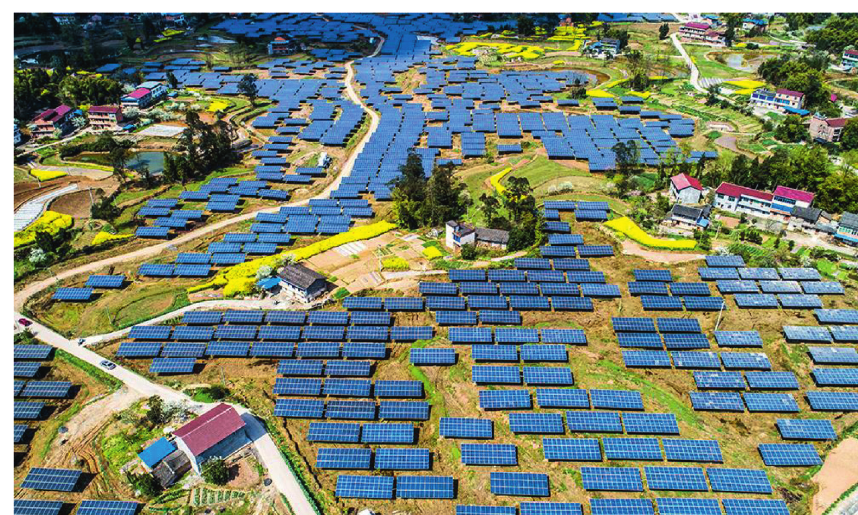
Figure 8: Photovoltaic power generation scene in Bade Village, Bashan Town, Zhong County, Chongqing. Chart source: Xinhua News Agency. Table 3: Comparison and analysis table of the advantages of energy storage solar stoves and traditional energy sources.